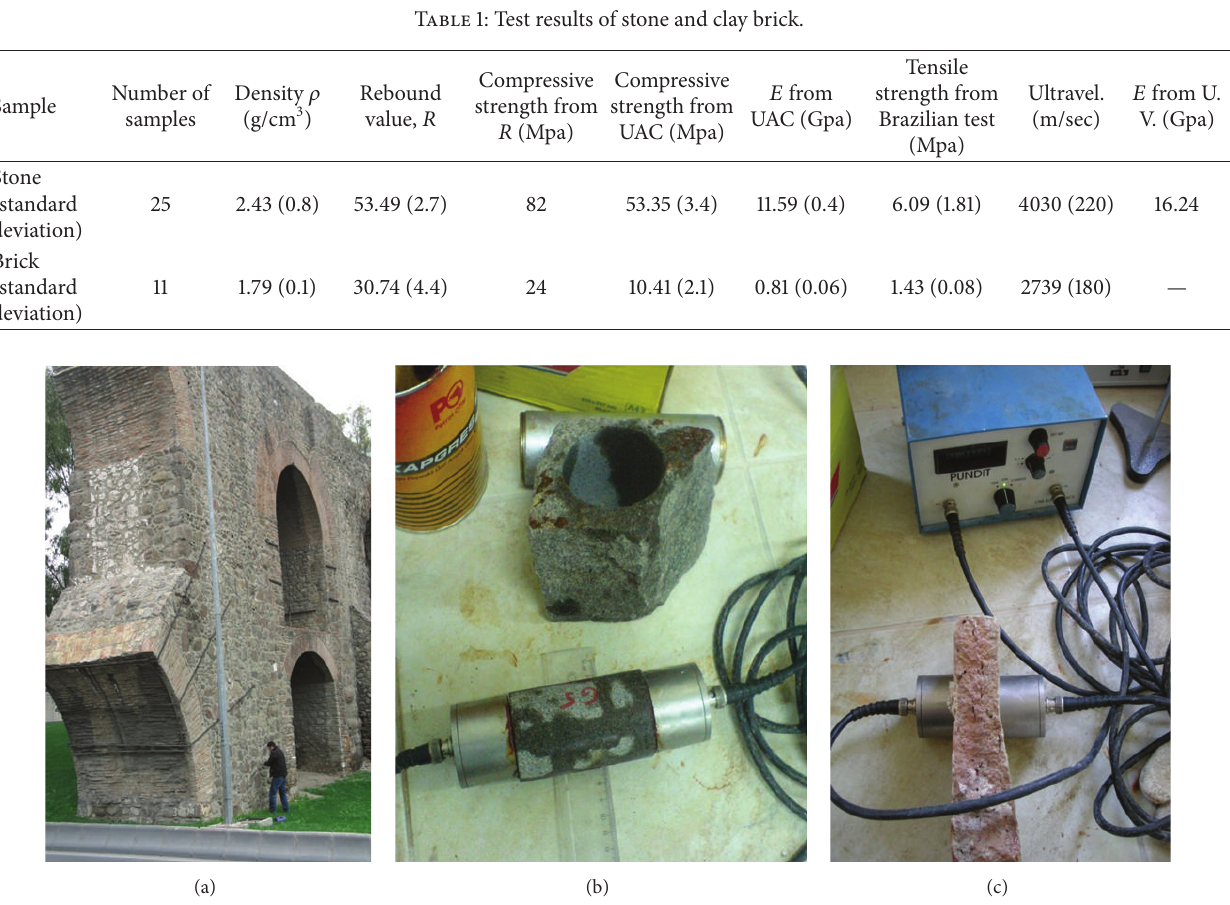
Figure 3: In situ Schmidt test and ultrasonic wave velocity test on stone and brick.